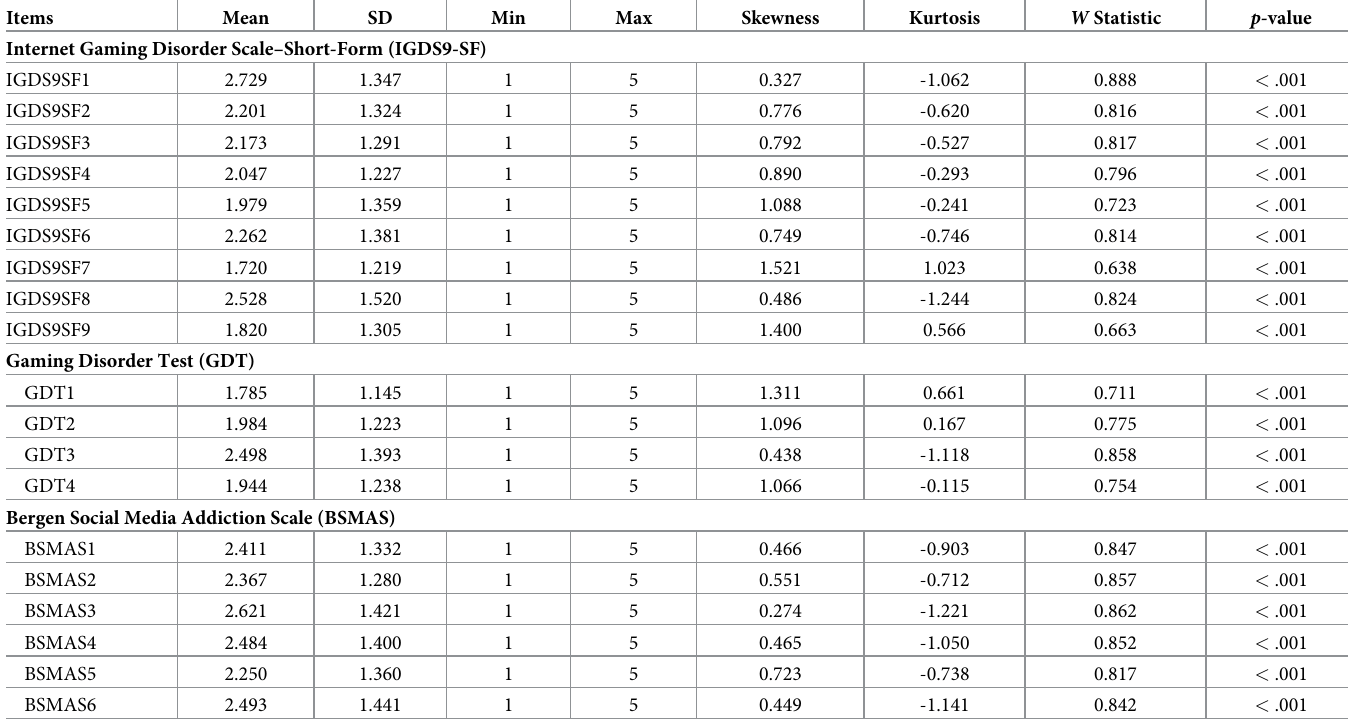
Table 1. Item-descriptive statistics, univariate and multivariate normality testing ( N =